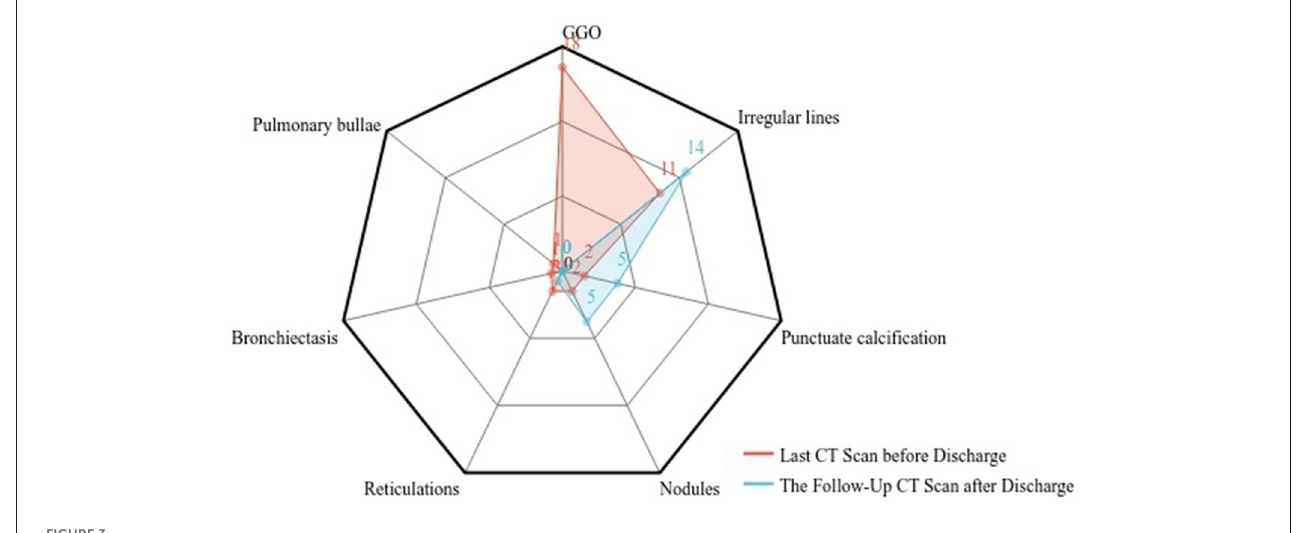
FIGURE3 Imaging features of follow-up CT and hospital discharge CT.